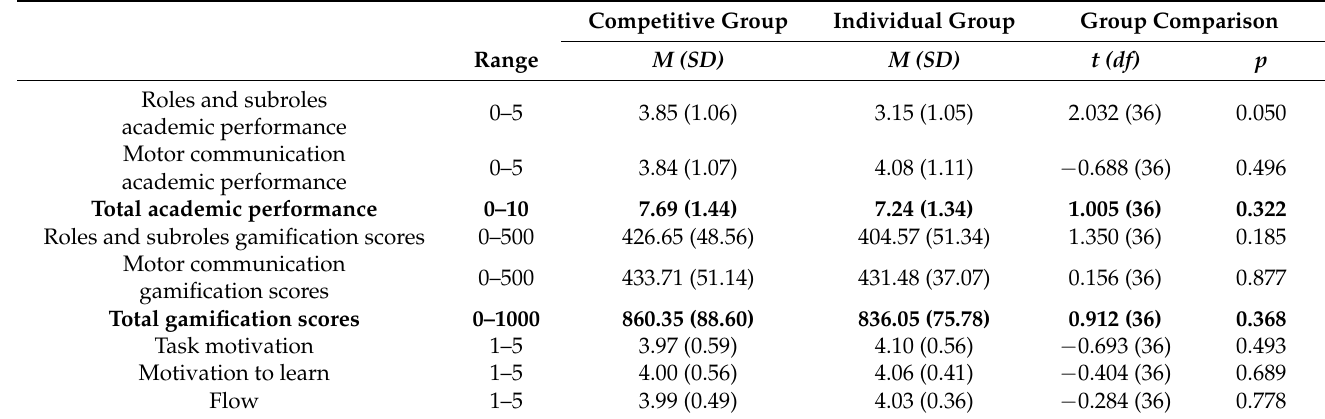
Table 3. Comparison between competitive and individual